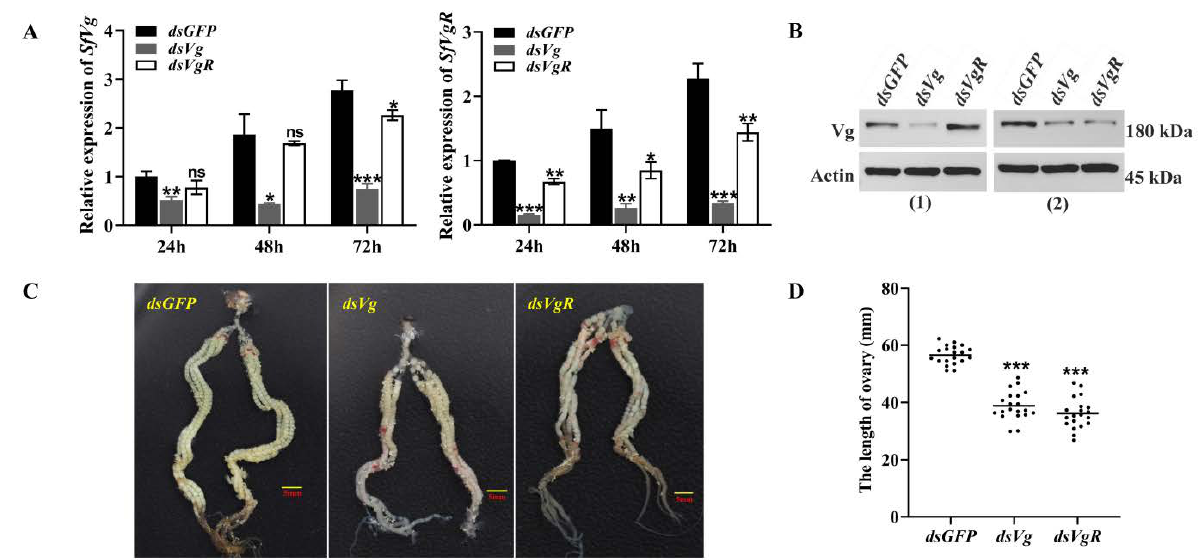
Figure 6. The effect of RNAi-mediated knockdown of SfVg and SfVgR on ovary development of S. frugiperda female adults. ( A ) Relative expression levels of SfVg and SfVgR in female adults at 24, 48, and 72 h after eclosion. The bar represents the mean ± SE of three biological repetitions. The asterisks indicate statistically significant differences and ns represents no significant difference between each treatment ( t -test: * p < 0.05, ** p < 0.01, *** p < 0.001). ( B ) The protein contents of Vg in hemolymph (1) and ovary (2) after dsRNA injection were detected by Western blot, with actin as an internal parameter. ( C , D ) Effect of SfVg and SfVgR silencing on ovarian development and length with GFP as a control. Ovaries were dissected 72 h after eclosion. The scale bar in the figures is 5 mm. The horizontal line in ( D ) represents the median .